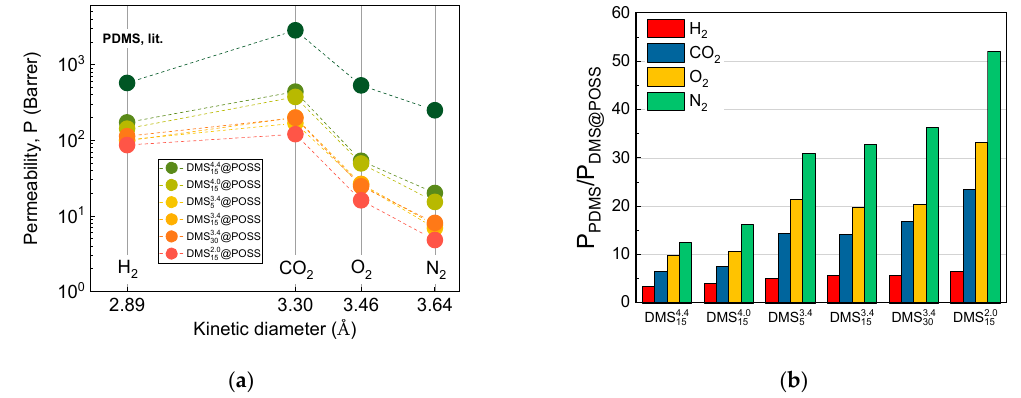
Figure 6. ( a ) Permeability of measured gases (H 2 , CO 2 , O 2 , N 2 ) in DMS x y @POSS membranes as a function of gas kinetic diameter compared to the PDMS [18], demonstrating similar pattern, however with a much higher permeability decrease compared to PDMS for larger gases evidencing influence of molecular size on permeability change; ( b ) Factor showing permeability decrease in all membranes compared to PDMS (for all gases).